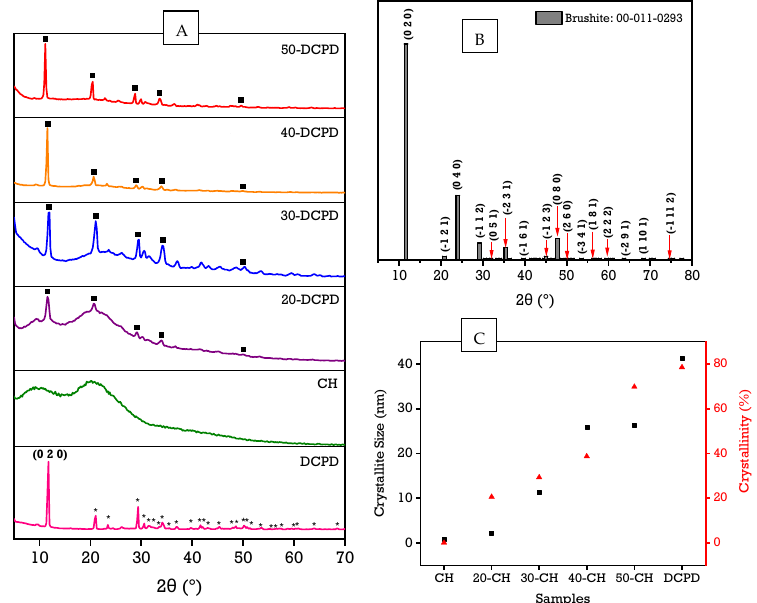
Table 2. Rietveld analysis, Bragg's law and Scherrer's equation were utilised to determine diffrac- tion plane indexes, crystallite size and crystallinity of the unloaded and DCPD mineral-loaded freeze-dried chitosan scaffolds. Figure 2. Normalised X-ray diffraction data, ( A ) Experimental XRD spectra for DCPD, CH, 20, 30, 40 and 50-DCPD samples, ( B ) DCPD reference spectra and ( C ) graph depicting the relationship between crystallite size and crystallinity. * corresponds to Bragg 2θ diffraction peaks of DCPD while ▪ corresponds to miller indices (0 2 0), (0 4 0), (−1 1 2), (−2 3 1) and (0 8 0) diffraction planes, respectively.